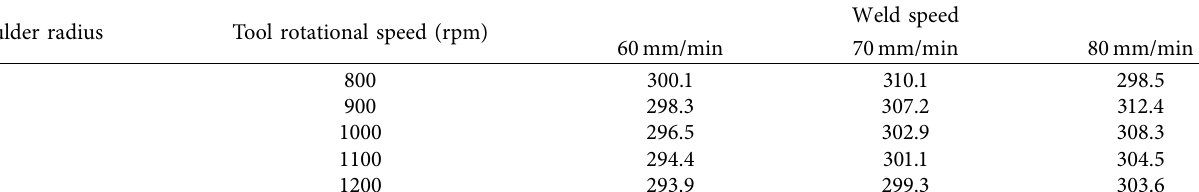
� 7.5 mm; (b) R � 9mm; (c) R � 10.5 mm; (d) shoulder shoulder shoulder